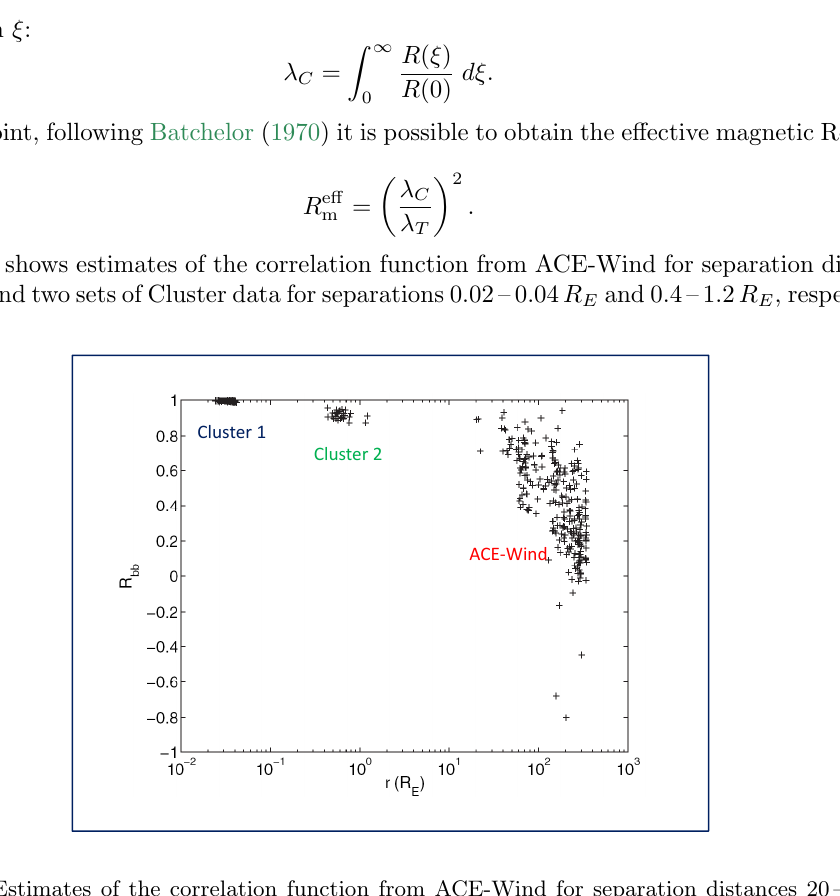
Figure 27: Estimates of the correlation function from ACE-Wind for separation distances 20 – 350 𝑅 𝐸 and two sets of Cluster data for separations 0 . 02 – 0 . 04 𝑅 𝐸 and 0 . 4 – 1 . 2 𝑅 𝐸 , respectively. Image adapted from Matthaeus et al.